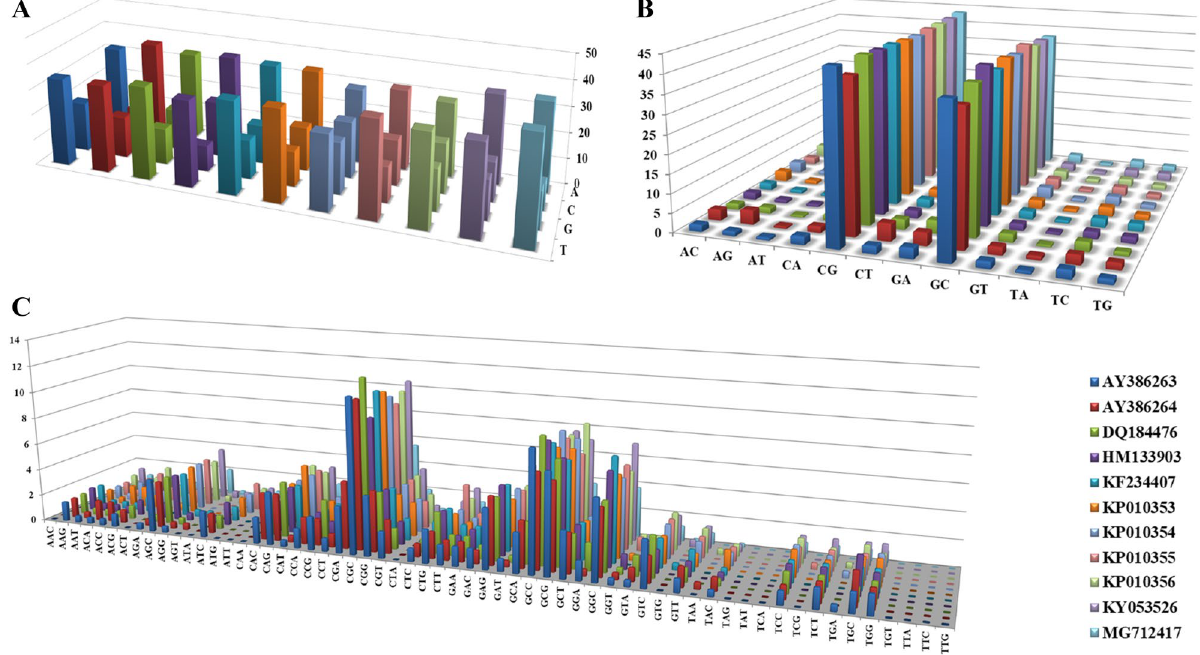
Figure 3. Types of SSRs distribution. ( A ) Distribution of different motifs of mononucleotide SSRs within ORFV genomes, ( B ) distribution of different motifs of dinucleotide SSRs within ORFV genomes, and ( C ) distribution of different motifs of trinucleotide SSRs within ORFV